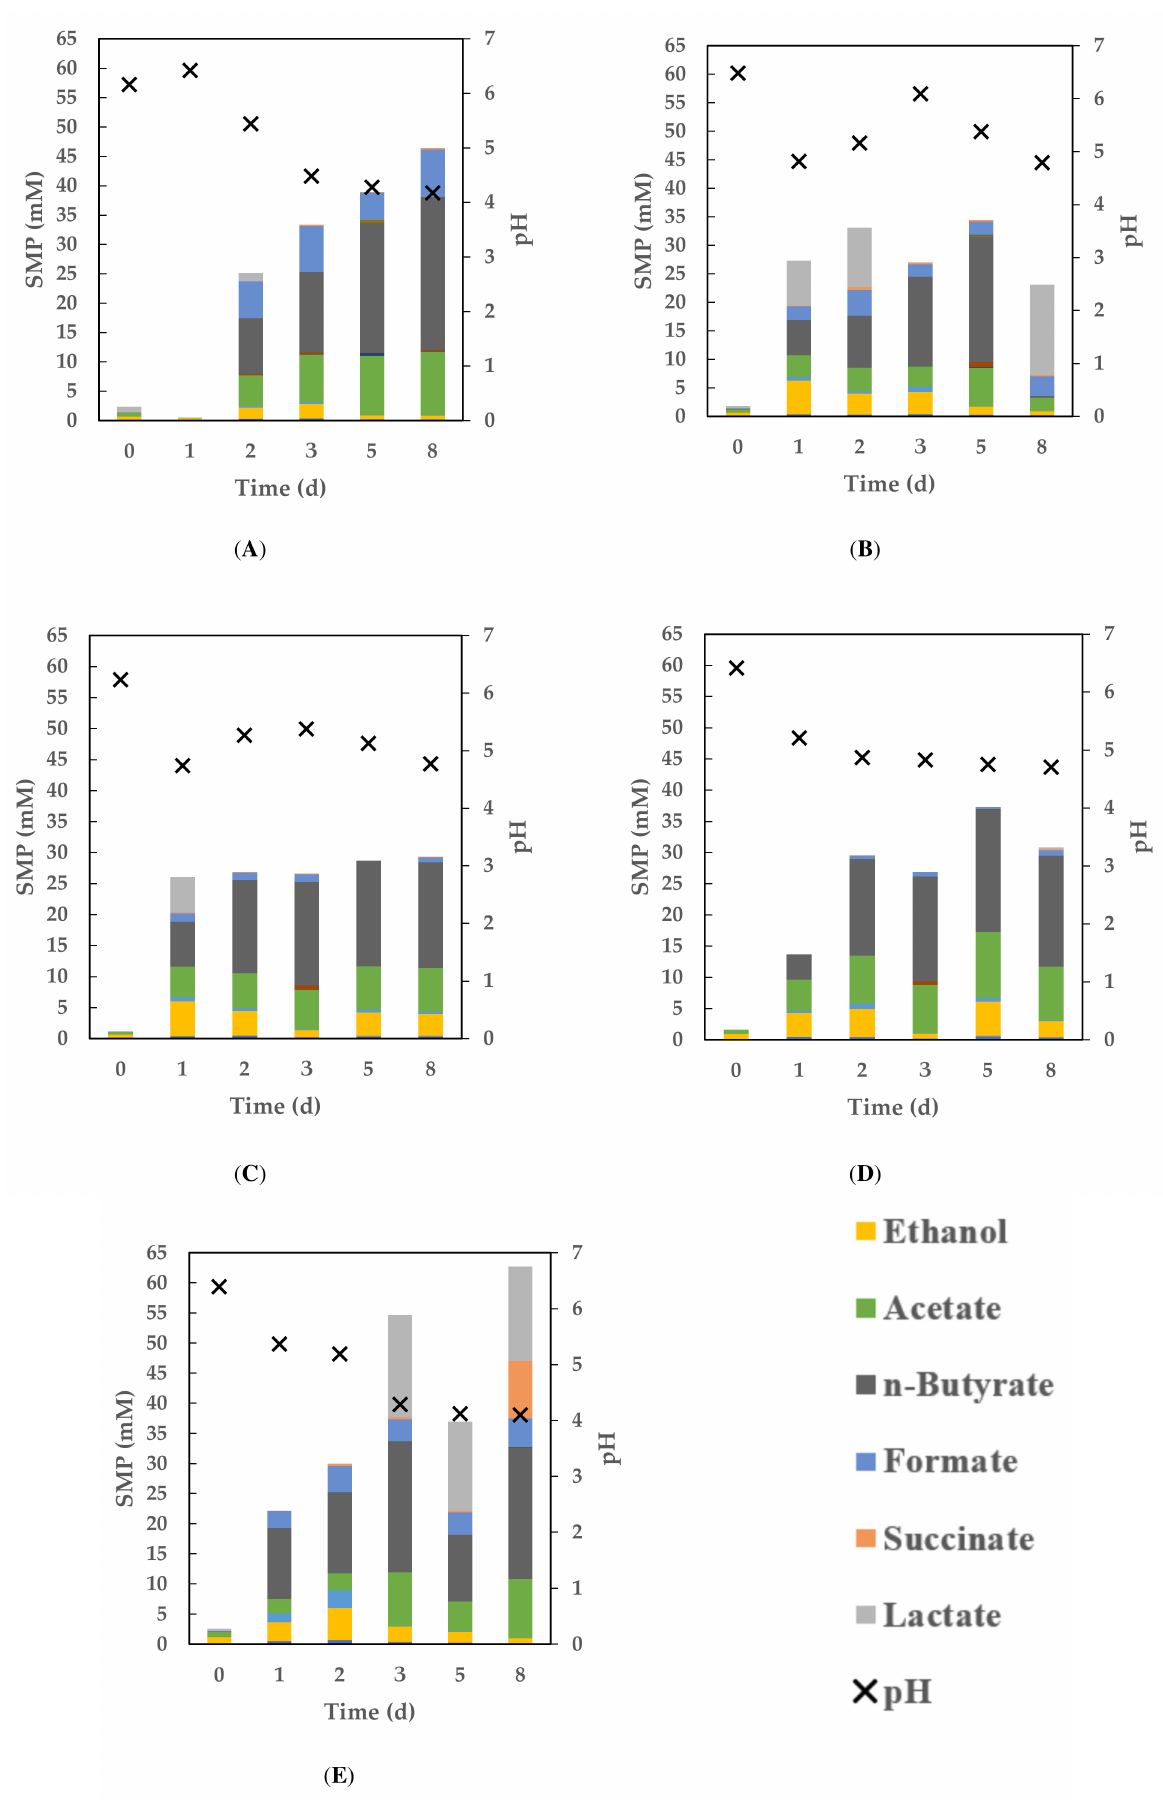
Figure 5. Dynamics of soluble metabolite products (SMP) and pH during DF of CW, pretreated in VLA: ( A )—0 s, ( B )—5 s, ( C )—20 s, ( D )—45 s, ( E )—90